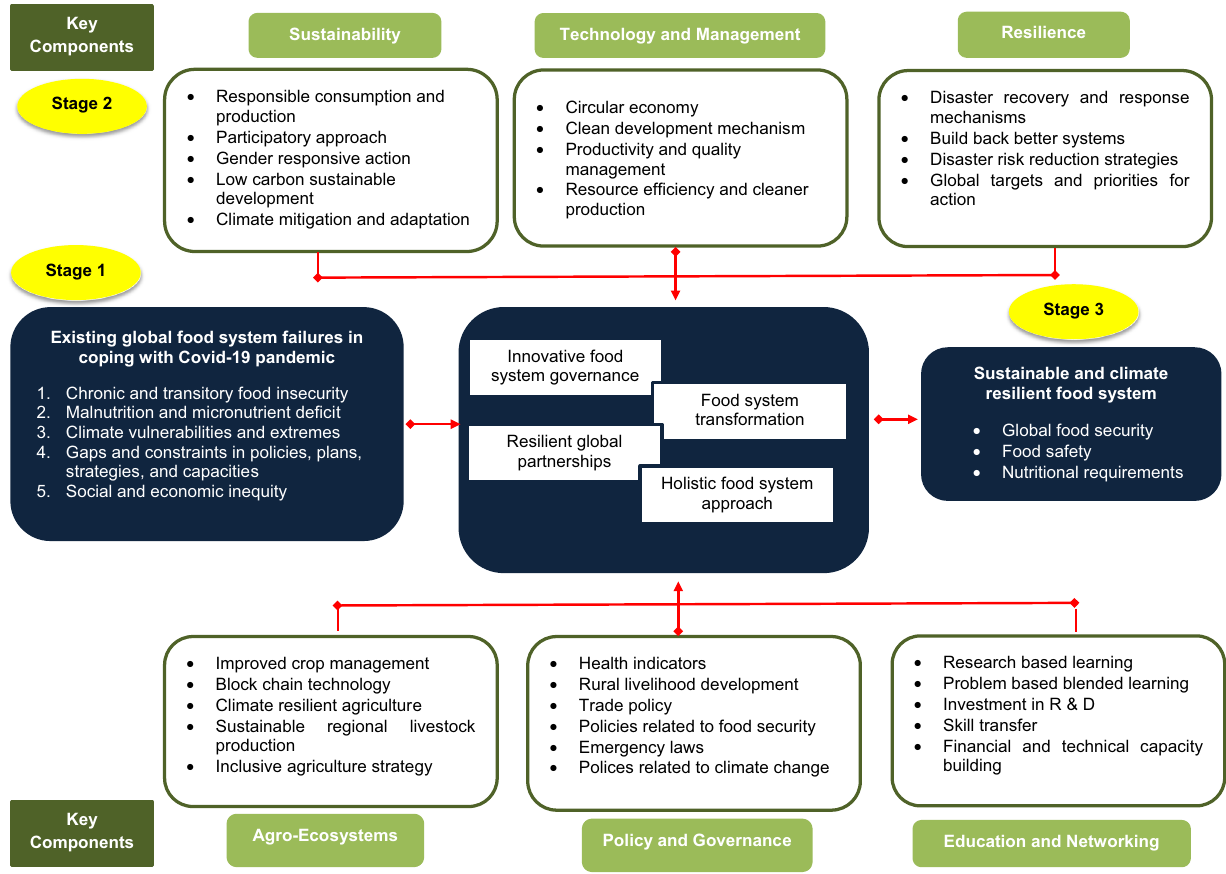
Fig. 7 Conceptual Framework on ensuring global food security and building pandemic resilient food system: towards accomplishing SDG